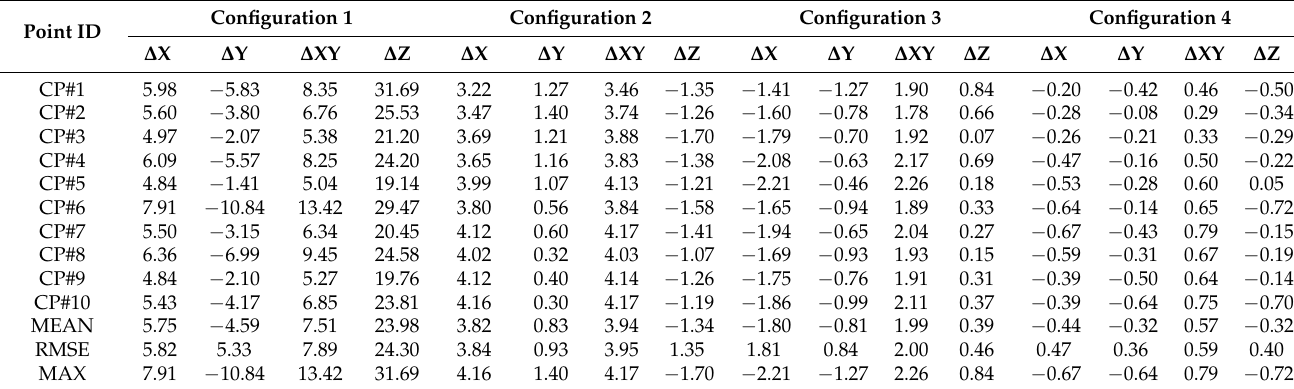
Figure 11. Shipborne photogrammetric 3D model of the Gongjiafang segment of the WLFZ and the distribution of the ten checkpoint points (CPs) (the red dots) as well as the distribution of the five ground control points (GCPs) in BBA Configuration 3 (the crosses). The CPs and GCPs were identified in the shipborne LiDAR data, and then they were projected onto the shipborne photogrammetric 3D model according to their coordinates. Table 4. Error statistics under different data processing configurations (Unit: m).